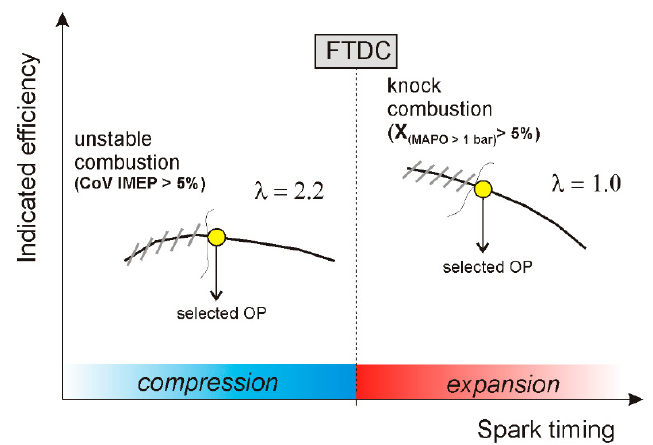
Figure 1. Illustration of applied methodology to define operating points with best indicated efficiency with imposed knock and combustion stability limits.